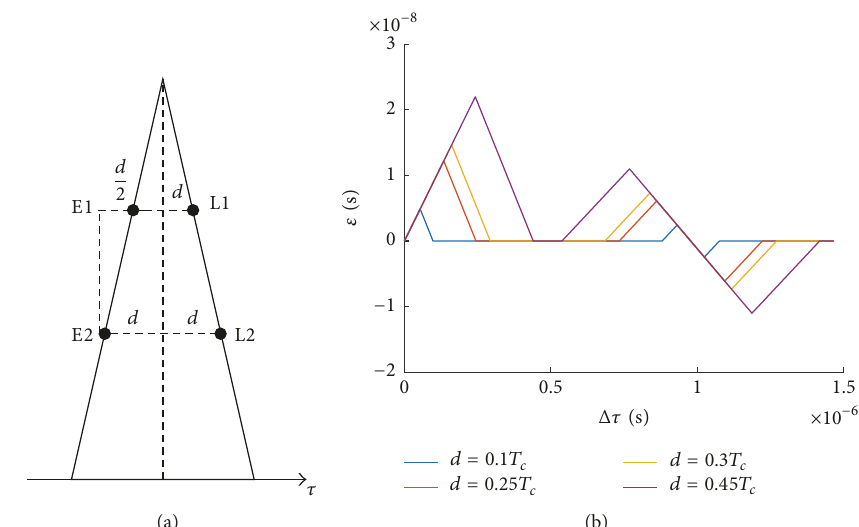
Figure 3: This figure shows the structure and the performance of the double-delta algorithm. (a) is the assignment of two pairs of correlators in double-delta algorithm. (b) is a plot of (14) where Δ𝜙 = 𝜙 𝑒 + Δ𝜙 0 is set to 0 for simplification. In the plot, 𝑇 𝑐 is set to 1/1.023𝑒6 as the chip /𝐴 width of GPS C/A code; 𝛼 = 𝐴 is set to 0.3 for demonstration. The plot shows PPE under different 𝑑 in double-delta algorithm. multipath direct